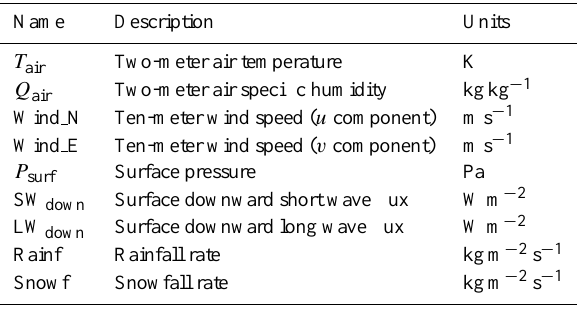
Table 1. List of atmospheric forcing variables in